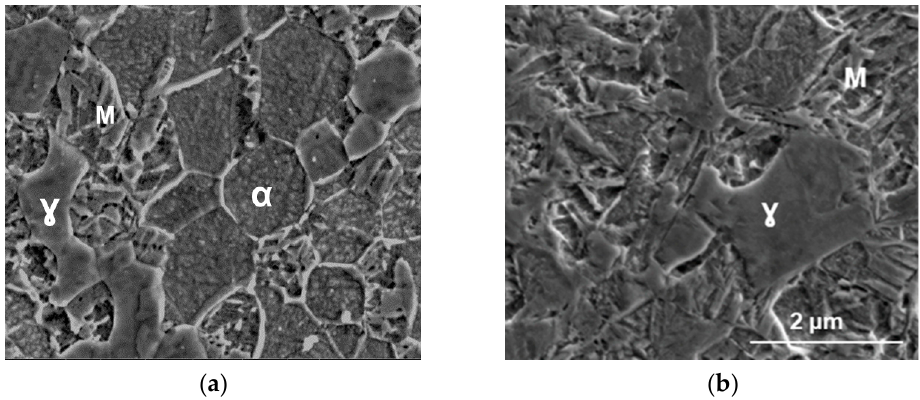
Figure 3. Example microstructures of a 7.14 Mn, 0.14 C (wt. pct.) steel ( a ) after intercritical batch annealing (first soak), and ( b ) after double soaking with a second soak of 30 s at 800 °C [10,11]. (Nital etch; SEM secondary electron images).